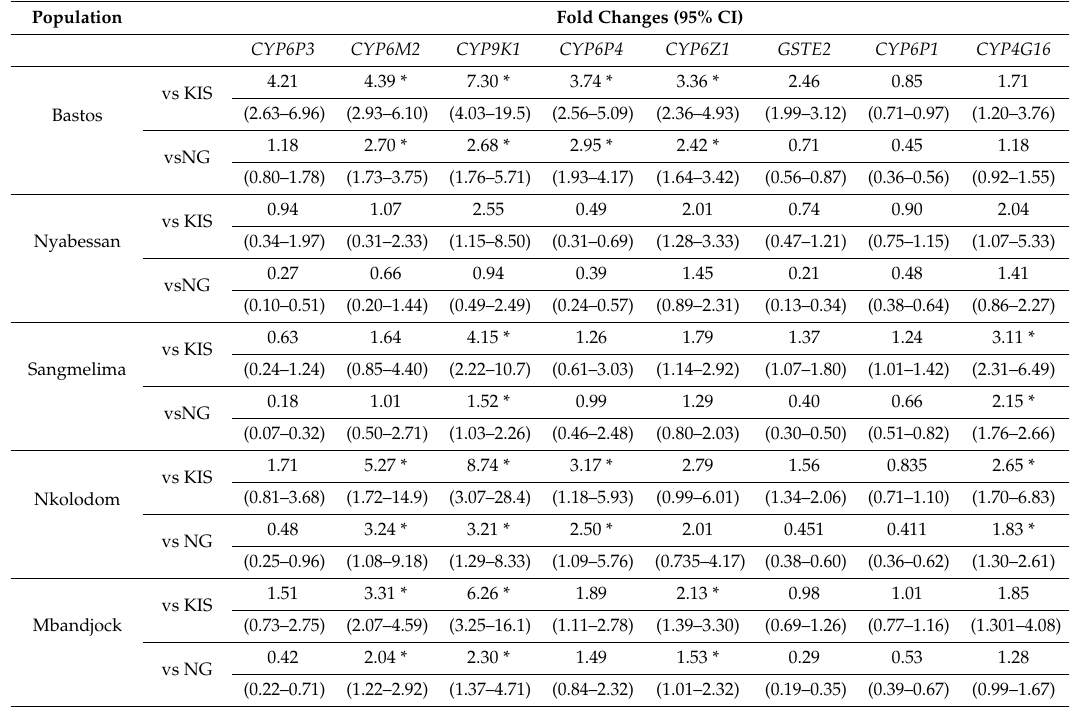
Table 4. Gene expression analysis in the five resistant mosquito populations compared to the susceptible strains. Bold letters indicate statistically significant upregulation, asterisks (*) indicate consistent upregulation compared to both susceptible